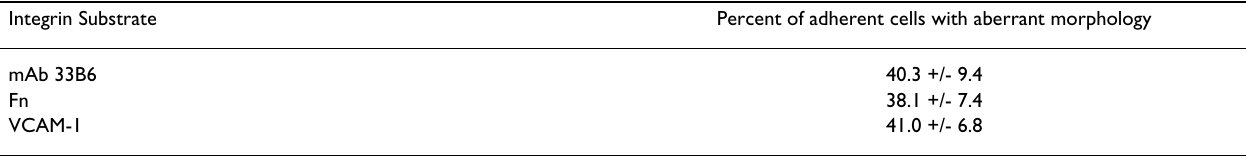
Table 1: Morphology of PMA + ionomycin activated primary T lymphocytes. Data represent averages and standard deviation from 3 separate experiments, and are expressed as the percentage of adherent cells demonstrating pseudopodia. All of the pseudopods observed were of the C3